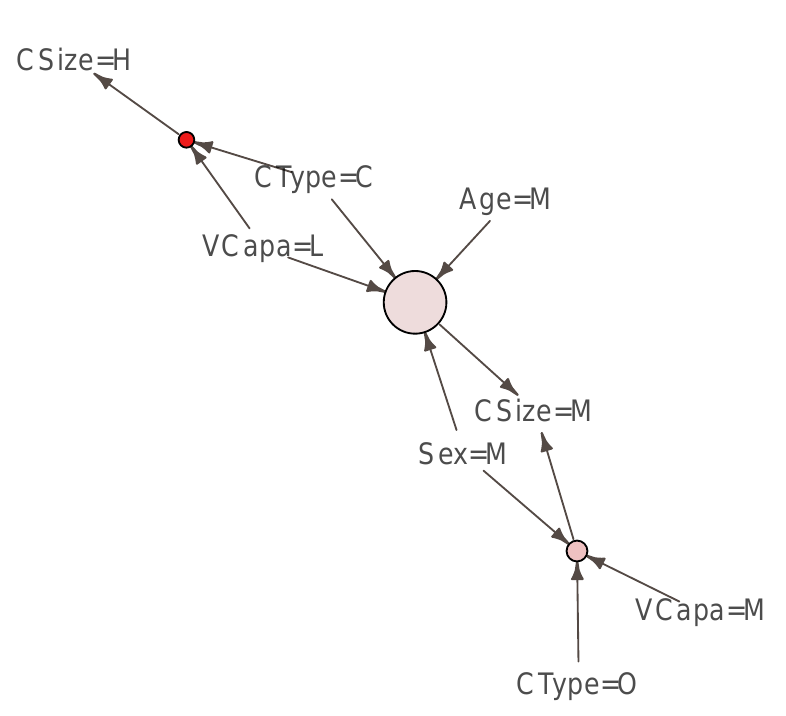
Figure 5. Graph of association rules for claim